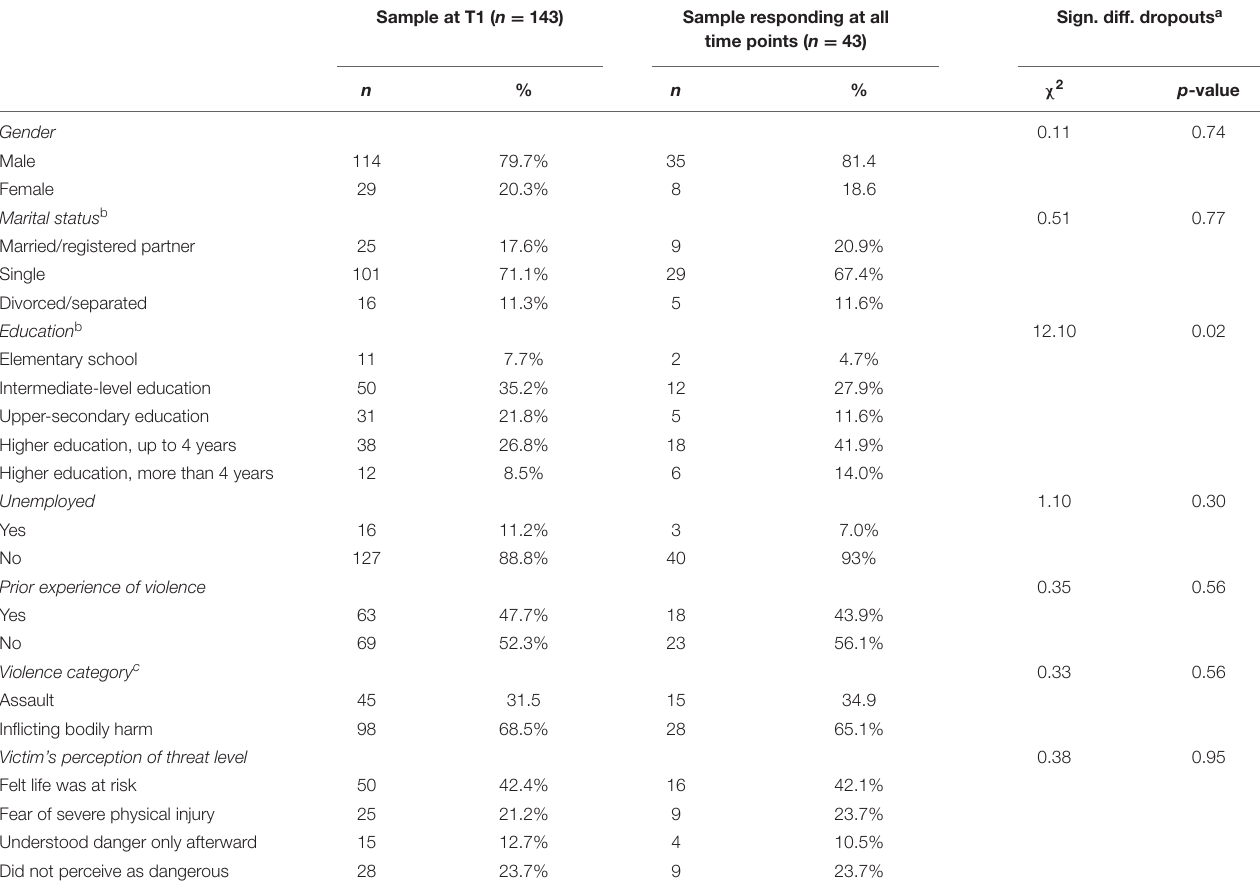
TABLE 1 | Descriptive information for participants at T1 ( n = 143) and those participating at all time points ( n = 43). Sample at T1 ( n = 143) Sample responding at all Sign. diff. dropouts time points ( n = 43)